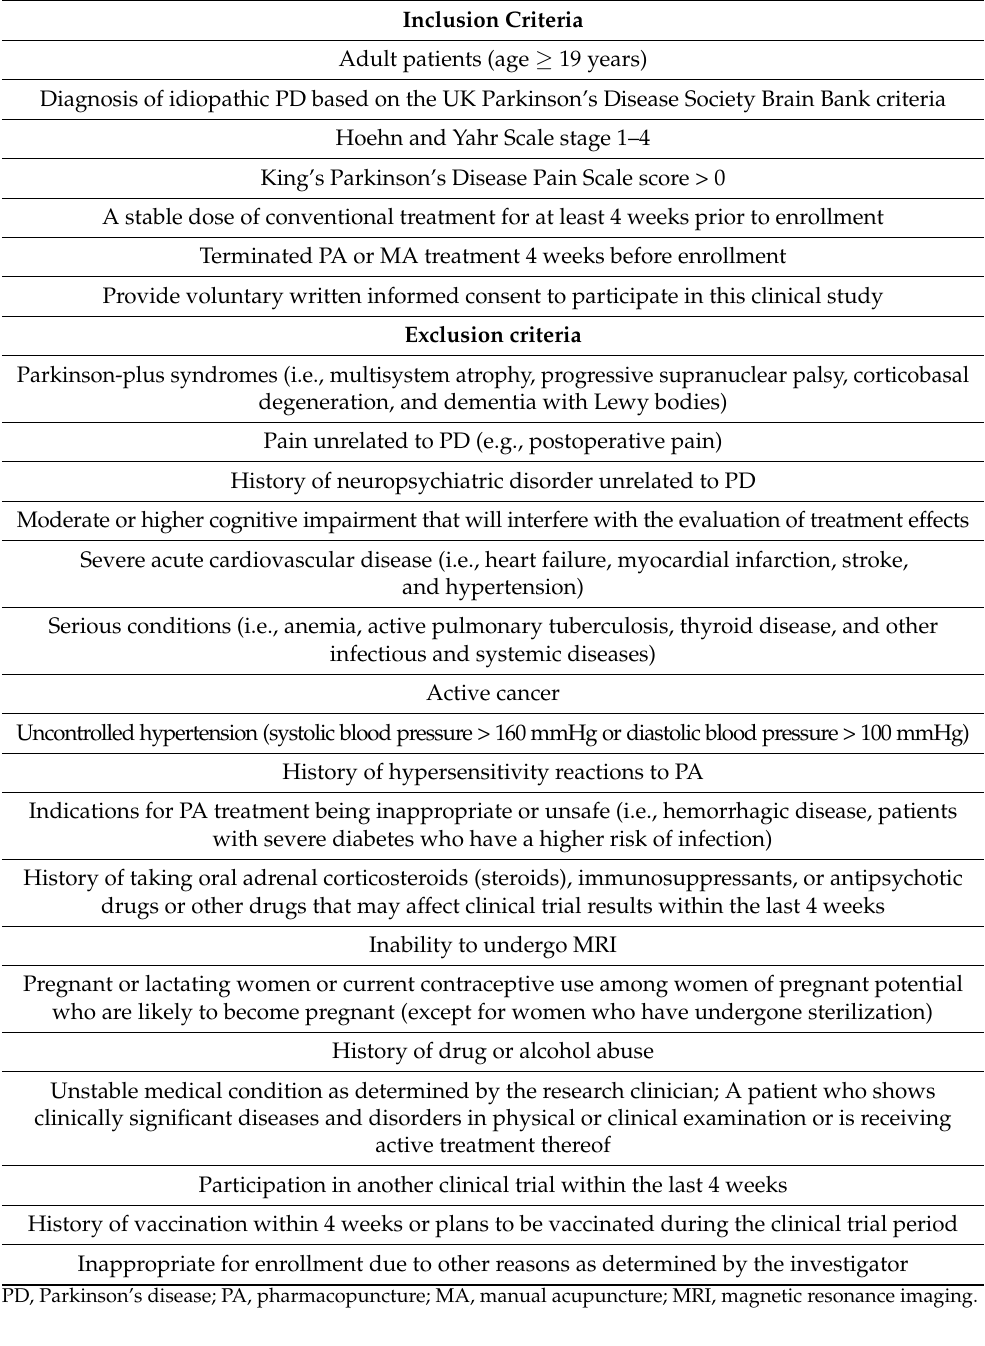
Table 1. Patient eligibility